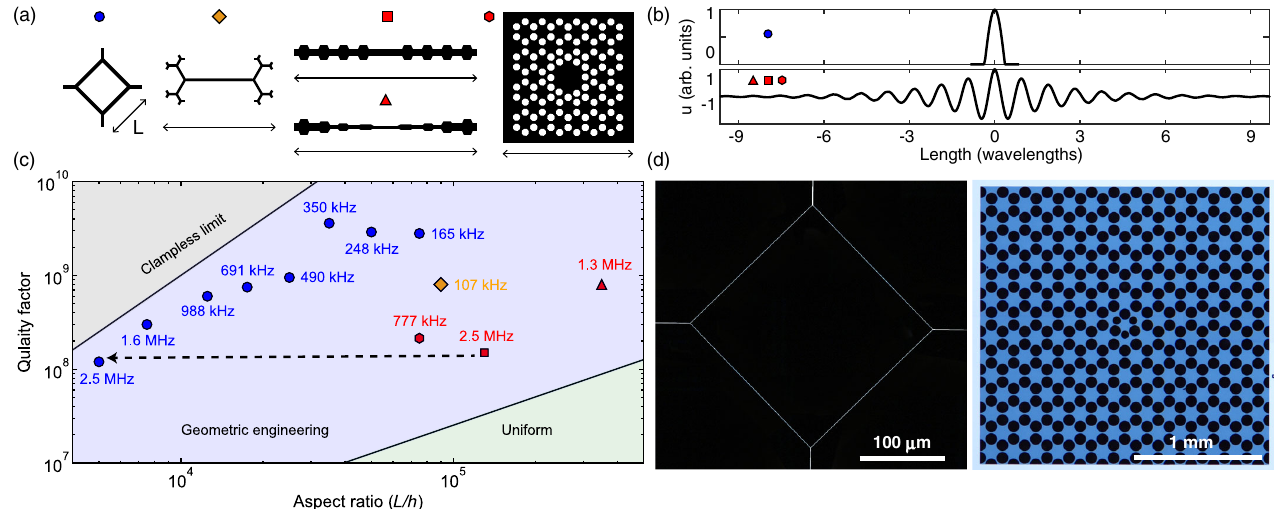
FIG. 1. Comparison of state-of-the-art strained mechanical resonator designs. (a) Schematics of different mechanical resonators with their spatial extent illustrated by double-headed arrows ( L ). From left to right: polygon resonator, binary tree nanobeam [13], phononic crystal nanobeam [15], strain engineered nanobeam [15], and phononic crystal membrane [11]. (b) Simulated displacement profile of perimeter modes (plotted between two adjacent clamps) and phononic crystal soft-clamped modes with the same frequency. (c) Measured room temperature Q for polygons (blue circles) with different aspect ratios ( L=h ) and the best reported values for other designs of tensioned resonators [11,13,15]. For each data point, the corresponding resonance frequency is written on the plot. The green shaded area is accessible for the fundamental mode of a tensioned nanobeam with 20 nm thickness ( h ). The solid black line separating the gray and blue shaded areas shows the clampless limit for a 20-nm-thick beam [Eq. (2)]. The dashed arrow compares a polygon ( Q ¼ 120 × 10 6 ) and a phononic crystal soft-clamped beam ( Q ¼ 150 × 10 6 ) with the same thickness ( h ¼ 20 nm) and frequency ( f ¼ 2 . 5 MHz), showing 26 times lower aspect ratio for the polygon resonator, given the particular number of unit cells ( n ¼ 26 ) chosen for the phononic crystal soft-clamped beam in Ref. [15]. (d) Size comparison between a 200 - μ m-long polygon resonator with Q ¼ 155 × 10 6 at 1.6 MHz and a 2 × 2 mm 2 phononic crystal membrane with Q ¼ 74 × 10 6 at 1.46 MHz frequency [22], illustrating the reduced